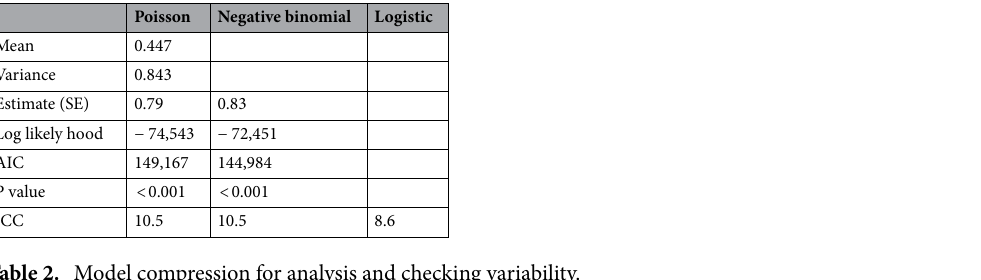
Table 2. Model compression for analysis and checking